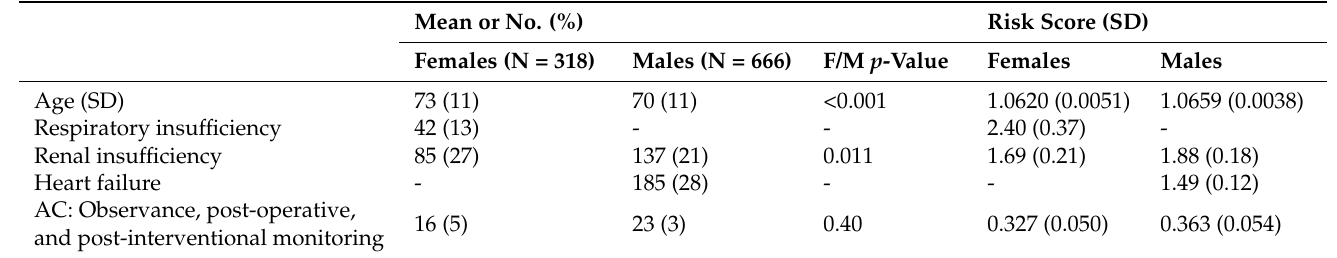
Table 3. Pre-ICU covariates for outcome “death”. Table shows case numbers in the sub-cohorts as well as the averaged regression coefficients for the selected features. Mean or No. (%)